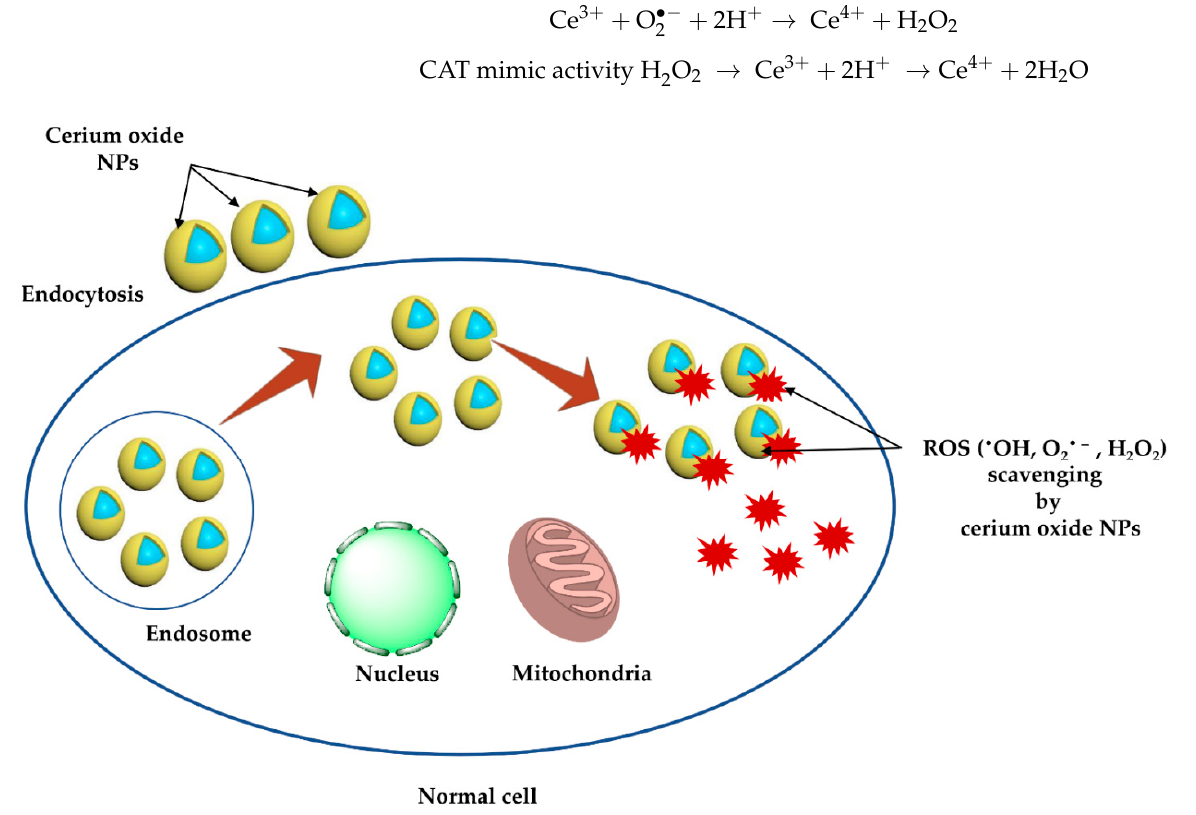
Figure 5. Antioxidant effect of cerium oxide NPs in normal cell under physiological pH via endocytosis and then scavenging ROS, such as • OH, O 2 •− , and H 2 O 2 as a result of SOD mimetic activity, by which O 2 •− is reduced to H 2 O 2 and CAT activity by which H 2 O 2 is further degraded into H 2 O, and hence providing protection to normal cells.